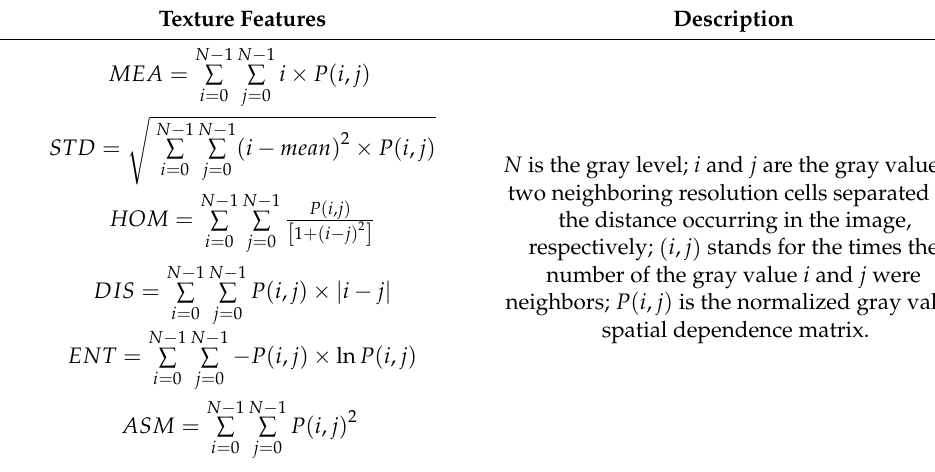
Table 5. Calculation Equations of texture